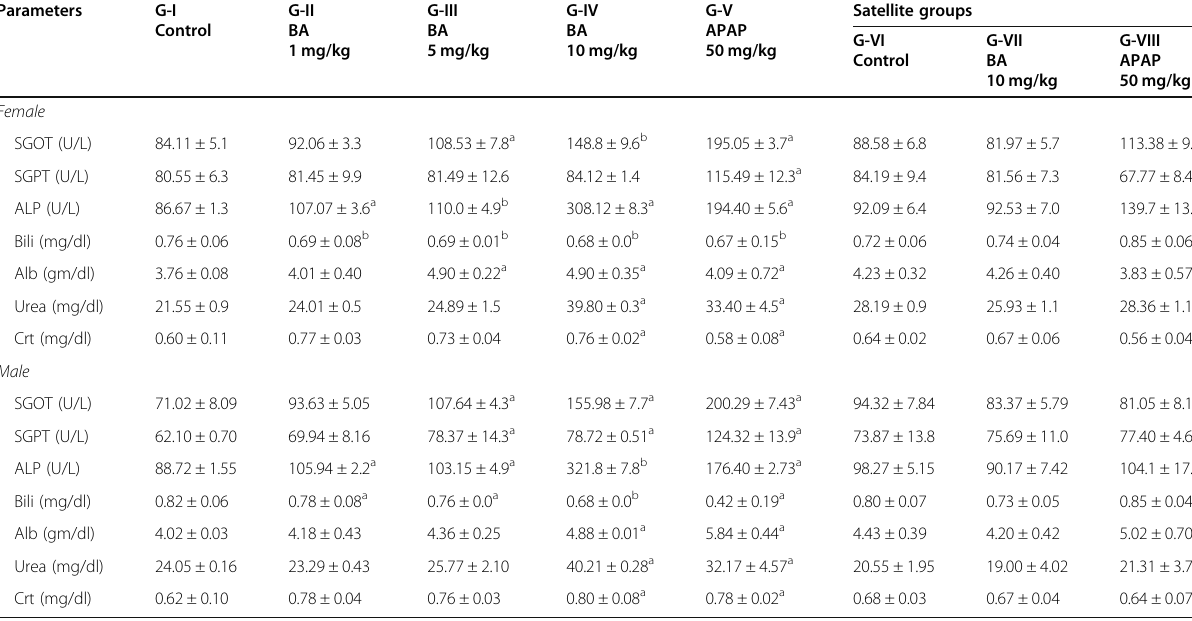
Table 5 Effects of sub-acute oral administration of BA and APAP on selected biochemical parameters of Wistar rats ( n = 5/sex)